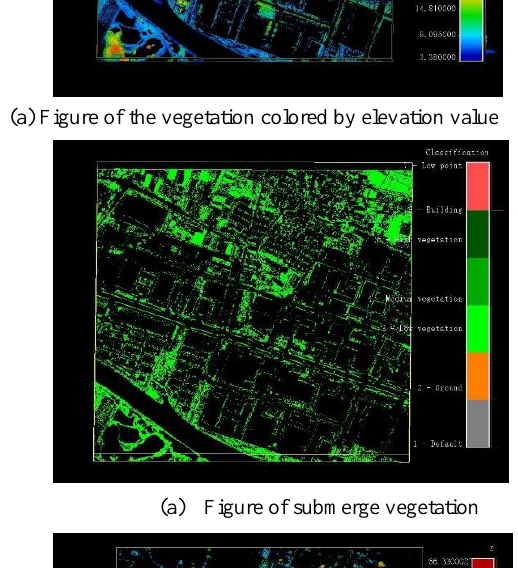
(a) Figure of the vegetation colored by elevation value